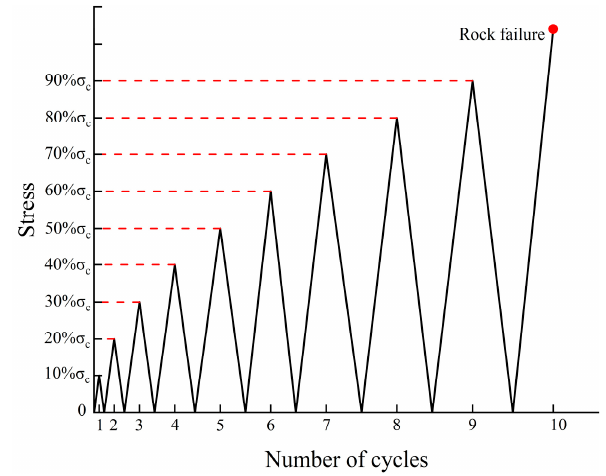
Figure 3. The stress path of constant lower limit cyclic loading and unloading (CLLCL).